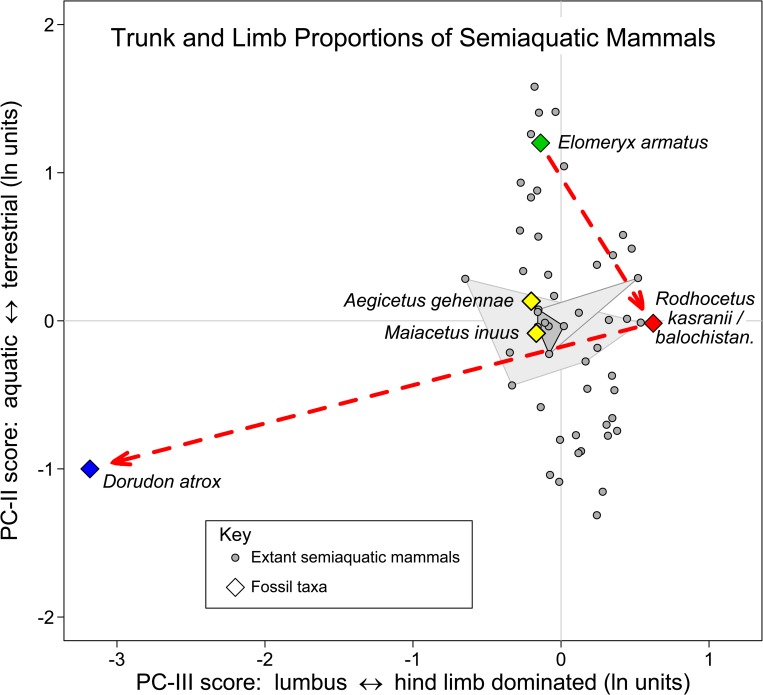
Transition of whales from land to sea (red arrows).Principal components plot shows trunk and limb skeletal proportions for the artiodactyl Elomeryx armatus, the protocetids Rodhocetus kasranii / balochistanensis, the basilosaurid Dorudon atrox, and a representative sample of 50 extant semiaquatic mammals. Aegicetus gehennae and Maiacetus inuus are similarly aquatic to Rodhocetus (PC-II) but less specialized as hind-limb swimmers (PC-III). Layered convex polygons (light gray) represent aquatic insectivores, all otters, and river otters, respectively. Aegicetus and Maiacetus fall near the extant giant otter (Pteronura brasiliensis) in this representation of skeletal proportions. Background and comparative data are provided in [50]. Dashed red line shows the generalized path through the morphospace followed during the transition from terrestrial mammals (green diamond) to protocetids (red and yellow diamonds) to basilosaurids (blue diamond). Modern cetaceans are lumbus-dominated and would fall to the left of the chart if they retained all of the skeletal elements measured here.